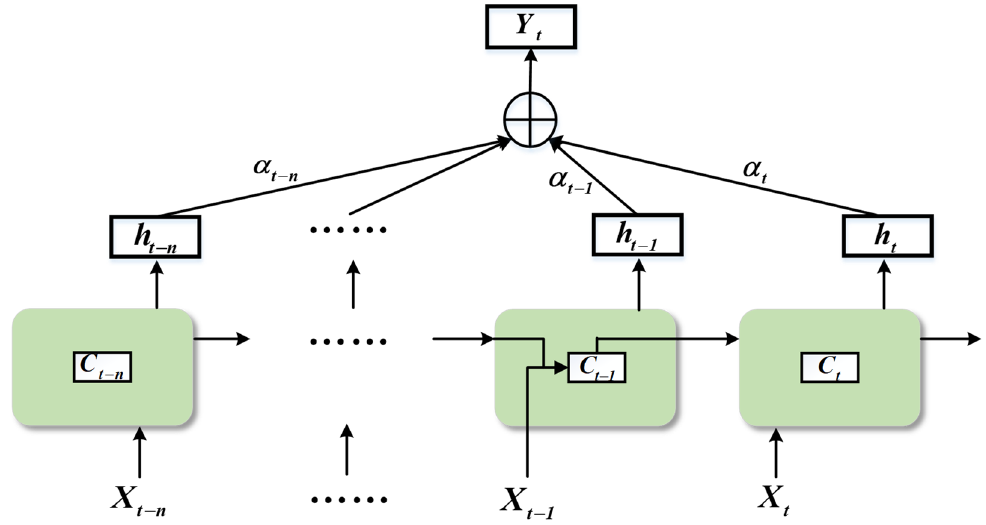
Figure 6. The ConvLSTM layer and attention layer. The attention layer takes the output h t of each iteration of ConvLSTM as input. At time t , normalized weights AT ( h t ) are computed by the softmax function through the weight W and the output h t of the ConvLSTM, the calculation formula is shown in